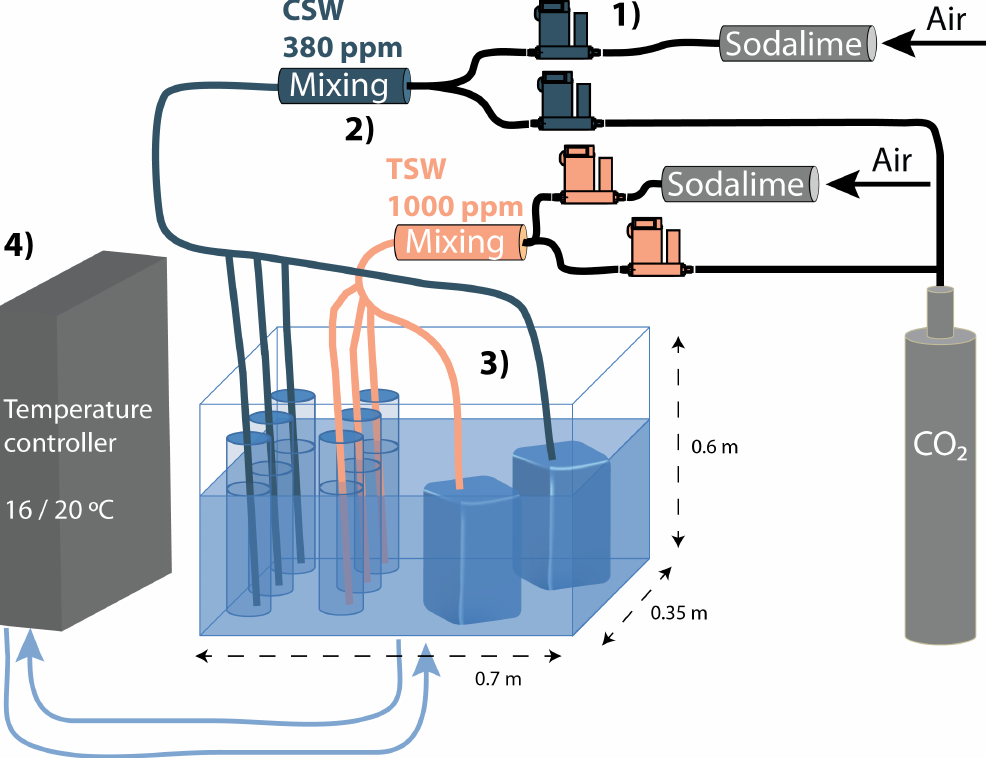
by soda-lime 2 gas and derive 2 controlled air. 2